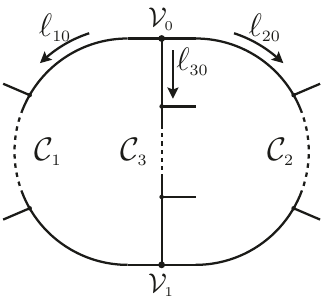
Figure 1 . A generic irreducible two-loop diagram consists of three chains C 1 , C 2 , C 3 . Each chain C i involves the various propagators depending on the loop momenta ‘ ia = q i + p ia , and q 1 + q 2 + q 3 = 0 . The two connecting vertices, V 0 , V 1 , can be triple or quartic